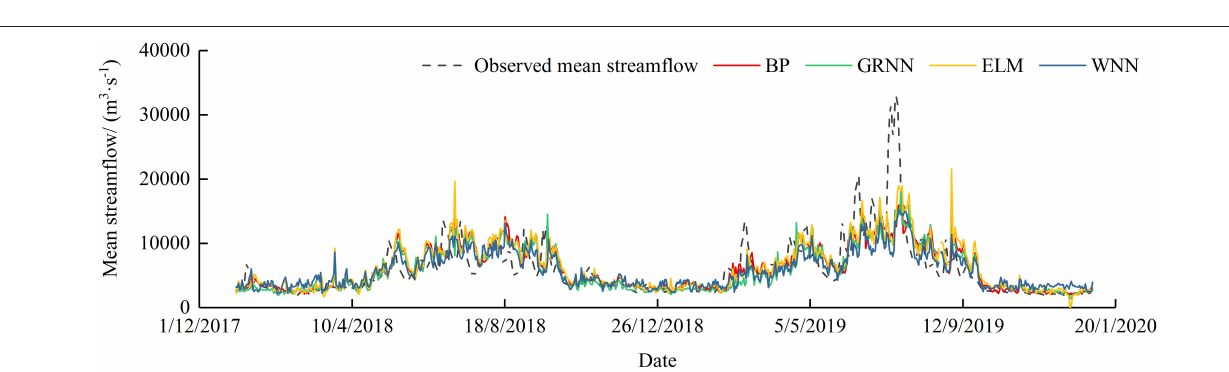
FIGURE 3 | Hydrographs of observed and simulated mean